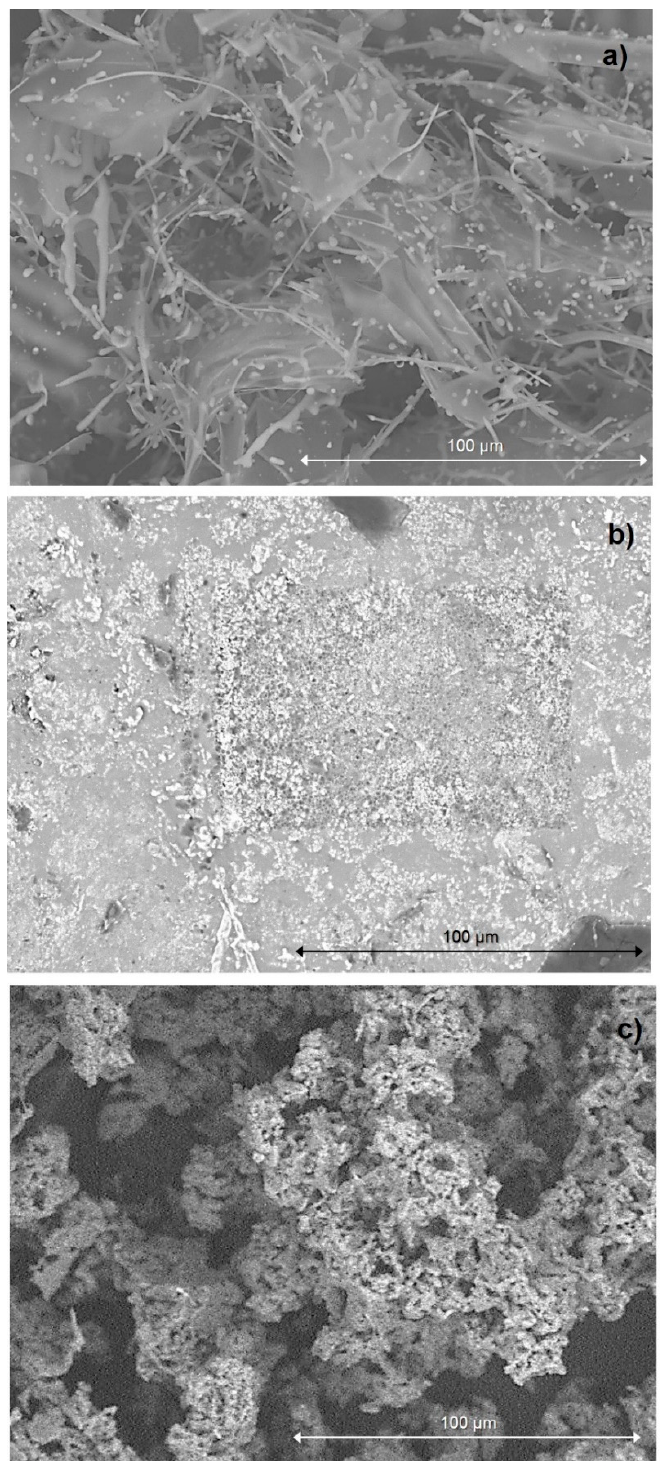
Figure 3. The SEM images of freeze-dried 1-week-old silver nanoparticle colloids obtained by: ( a ) classical method (AgNPs chemical); ( b ) biogenic method using potato waste (AgNPs potato); ( c ) biogenic method using parsley waste (AgNPs parsley), magnification ×1000. Spot analysis of microscopic images using an energy-dispersive X-ray microanalyzer combined with a scanning electron microscope (SEM-EDS) confirmed the presence of sil- ver in every colloid examined. This means that the nanostructures visible in the micro- images—uniformly distributed on the analyzed surfaces—were metallic nanoparticles.